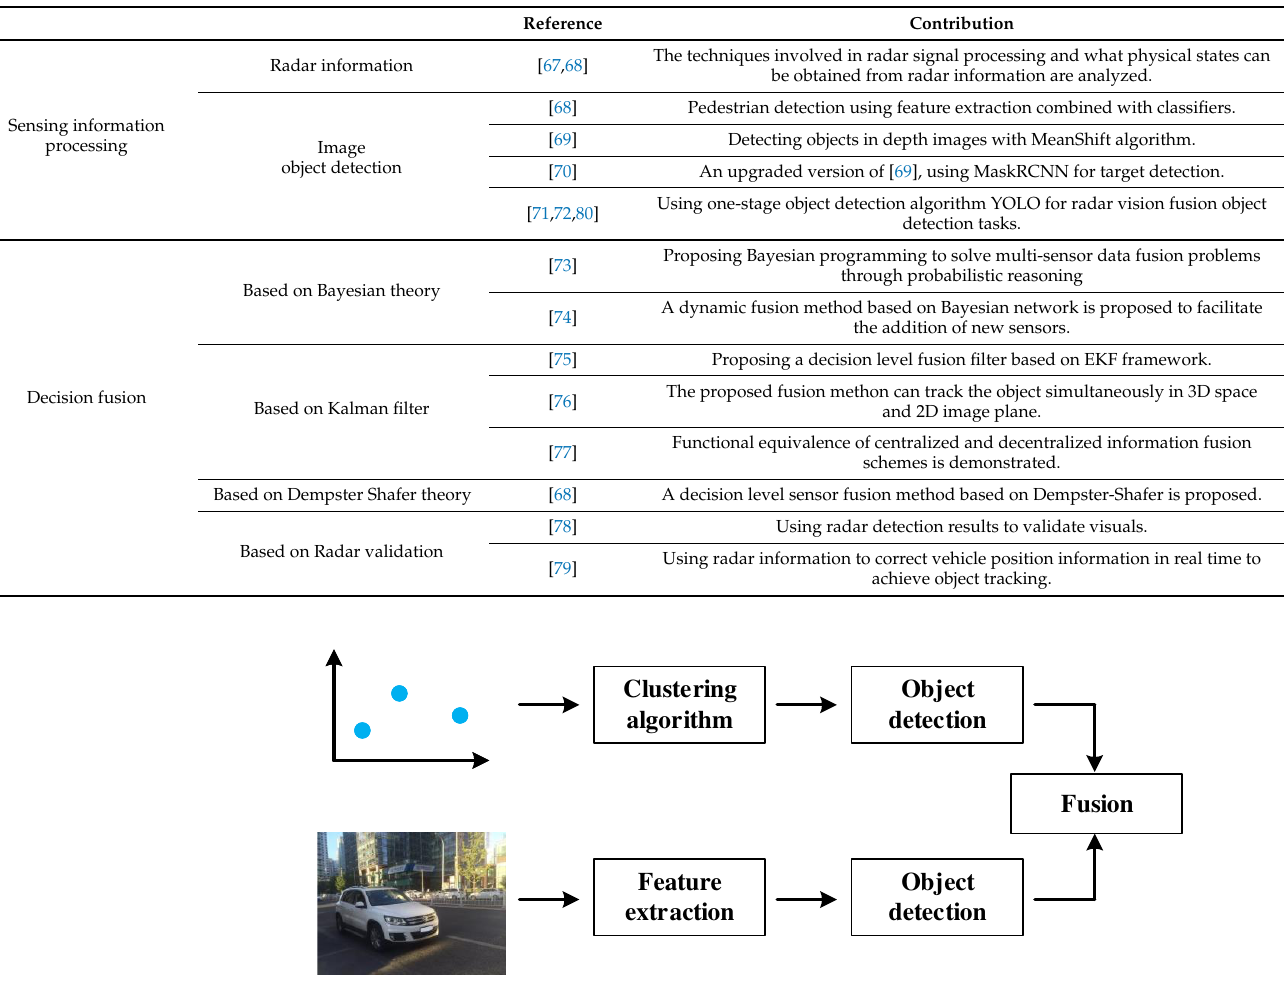
Table 6. Summary of decision level fusion.